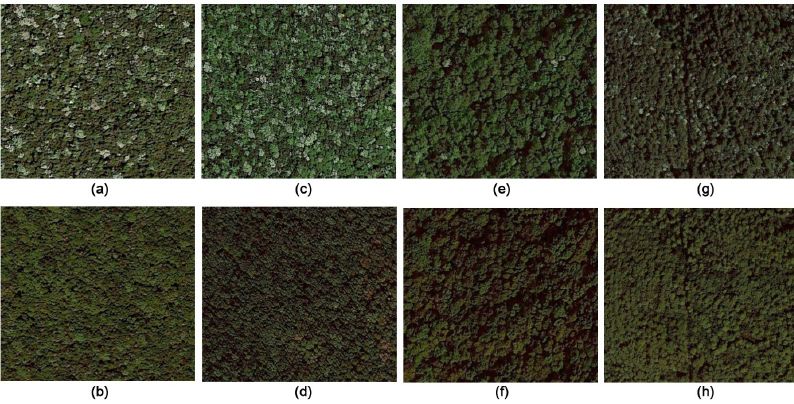
Figure A2. 26-Apr-2019 (above) and 31 Aug 2018 (under) Google Earth imagery used for photo-interpretation of the point training data. a,b) Cyclamino hederifolii-Quercetum ilicis. c,d) Cephalanthero longifoliae-Quercetum ilicis. e,f) Asparago acutifolii–Ostryetum carpinifoliae. g,h) Pinus halepensis and P. pinea plantation. Pictures a,c, and e) allow distinguishing of Cyclamino hederifolii-Quercetum ilicis from Cephalanthero longifoliae-Quercetum ilicis and Asparago acutifolii–Ostryetum carpinifoliae. In a) dark green, dominant, corresponds to Quercus ilex while flowering ash (Fraxinus ornus), the only deciduous species of this community, appears white because of the abundance of flowers. In c) the abundance of flowering ash (white) and other deciduous species (light green) such as Acer obtusatum, Ostrya carpinifolia, Sorbus sp. alternating with Quercus ilex (dark green), is very evident. In e) holm oak is absent, indeed only deciduous tall trees occur such as Ostrya carpinifolia, Acer obtusatum, and Fraxinus ornus; g) and h) are useful to recognize the occurrence of Pinus sp. plantations. These latter pictures clearly show the unique features of Pinus community of a vegetative grows in late summer. In h) the occurrence of light green is evident, while in g) it completely lacks.